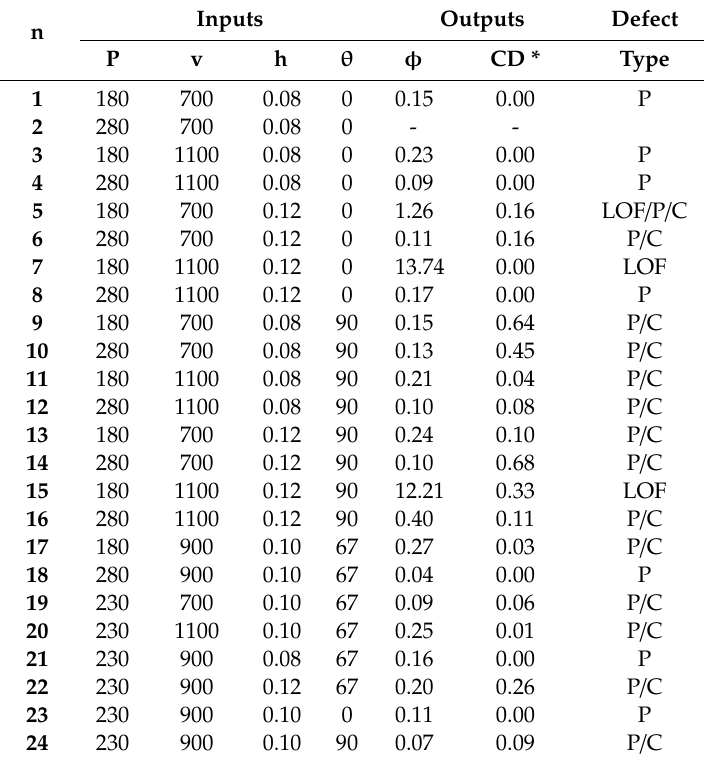
Table 3. Design of experiments and